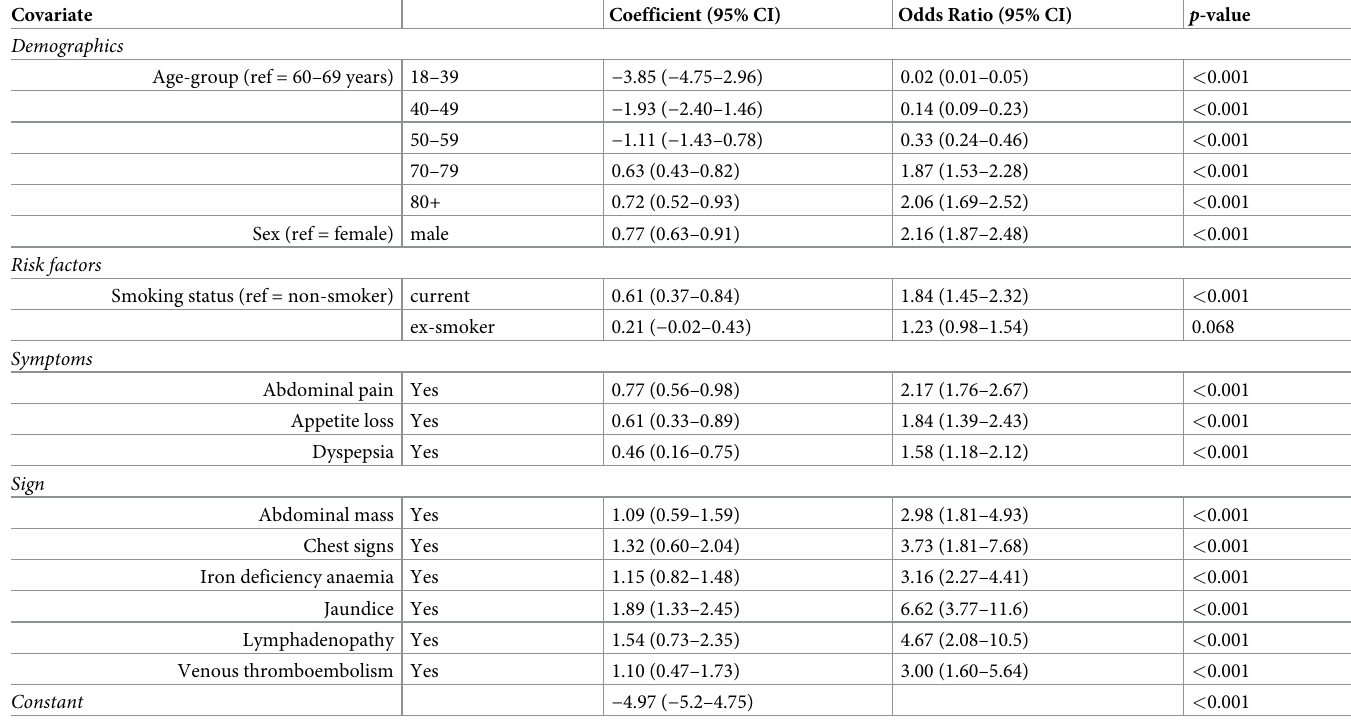
Table 2. Sm—Symptoms-only